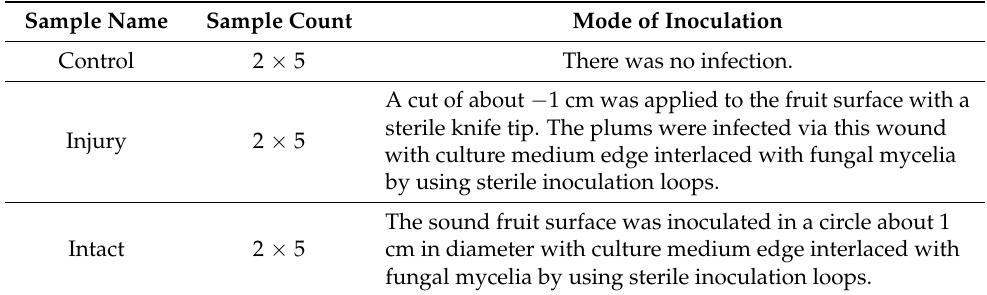
Table 1. Infection of plums with Monilia fructigena